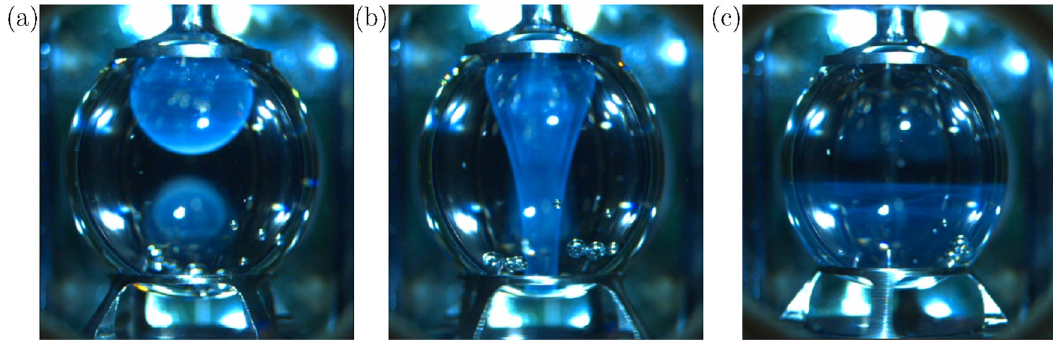
Fig. 4 Images of the native 2 mg/mL insulin case being seeded at 5.6 days with 0.4 mL of insulin fi brils. Panels show the injected volume ( a ) before and ( b , c ) after restarting ring rotation. Mixing of the turbid fi brillized volume allowed for visualization of the RSD's secondary fl ow (Fig. 1b and Supplement1.mp4).